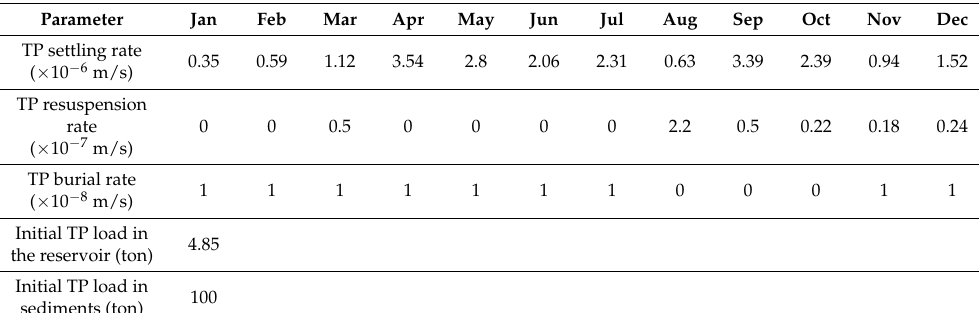
Table 5. The calibrated values for the parameters affecting the total phosphorus (TP) concentration in the reservoir.